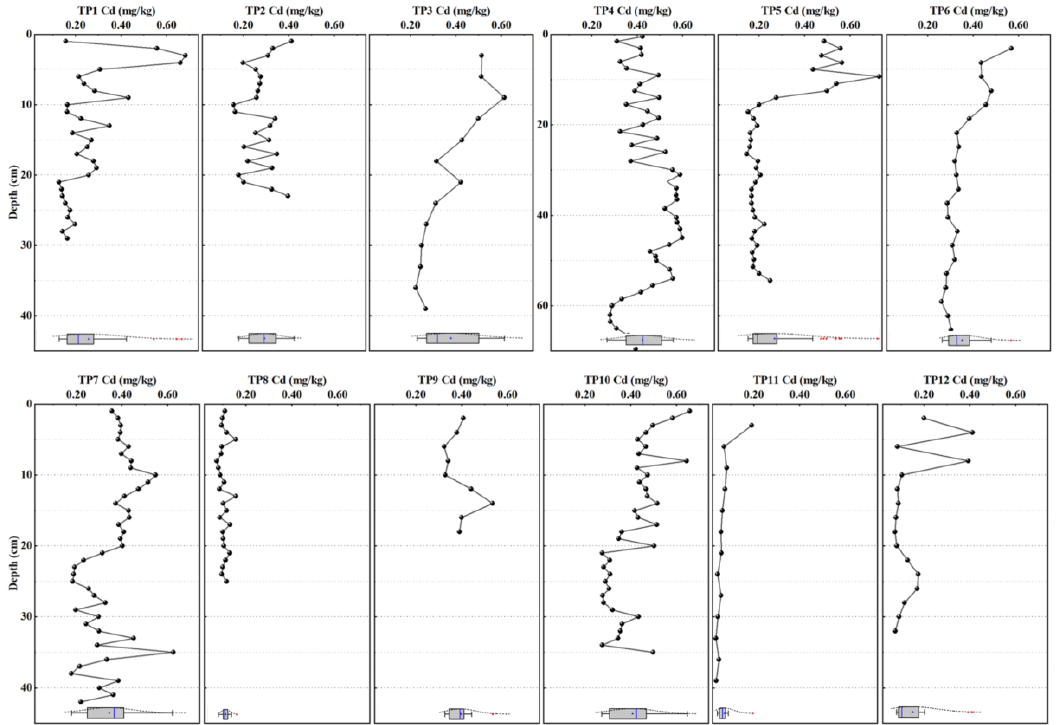
Figure 3. The vertical distribution of Cd in sediment cores sampled in the Taipu River (concentration of Cd (mg/kg): TP1: 0.13 – 0.68, TP2: 0.16 – 0.41, TP3: 0.22 – 0.61, TP4: 0.28 – 0.60, TP5: 0.15 – 0.73, TP6: 0.26 – 0.57, TP7: 0.18 – 0.62, TP8: 0.07 – 0.16, TP9: 0.32 – 0.54, TP10: 0.28 – 0.66, TP11: 0.03 – 0.19, TP12: 0.07 – 0.41).